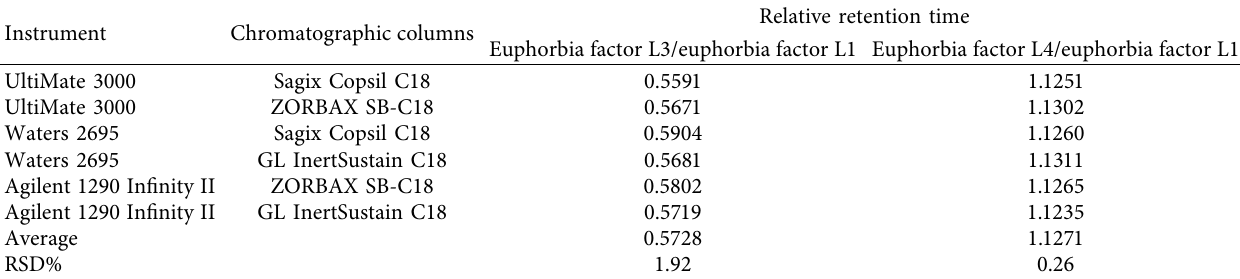
Table 8: Relative retention time measured by different brands of instruments and chromatographic columns. Instrument